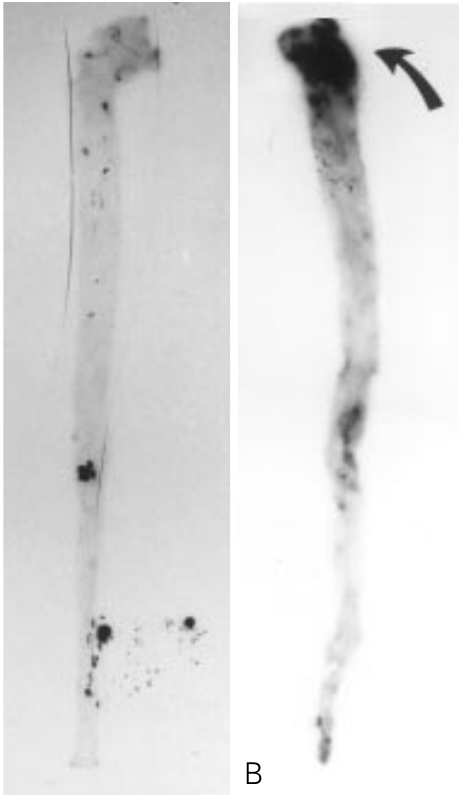
Figure 4 - Uptake of 99m Tc-nat- ß-VLDL and 99m Tc-ox-ß-VLDL by THP-1 macrophages (A) and rabbit monocyte-derived mac- rophages (B). Uptake was de- termined after incubating the cells with medium containing increasing concentrations of labeled lipoproteins for 4 h at 37 o C. The internalization of the 99m Tc-labeled ß-VLDL into cells was determined after solubilizing cells in 0.1 N NaOH and measuring the ra- dioactivity with a gamma- counter. Each point is the mean of triplicate determina- tions made in 2-3 experi-